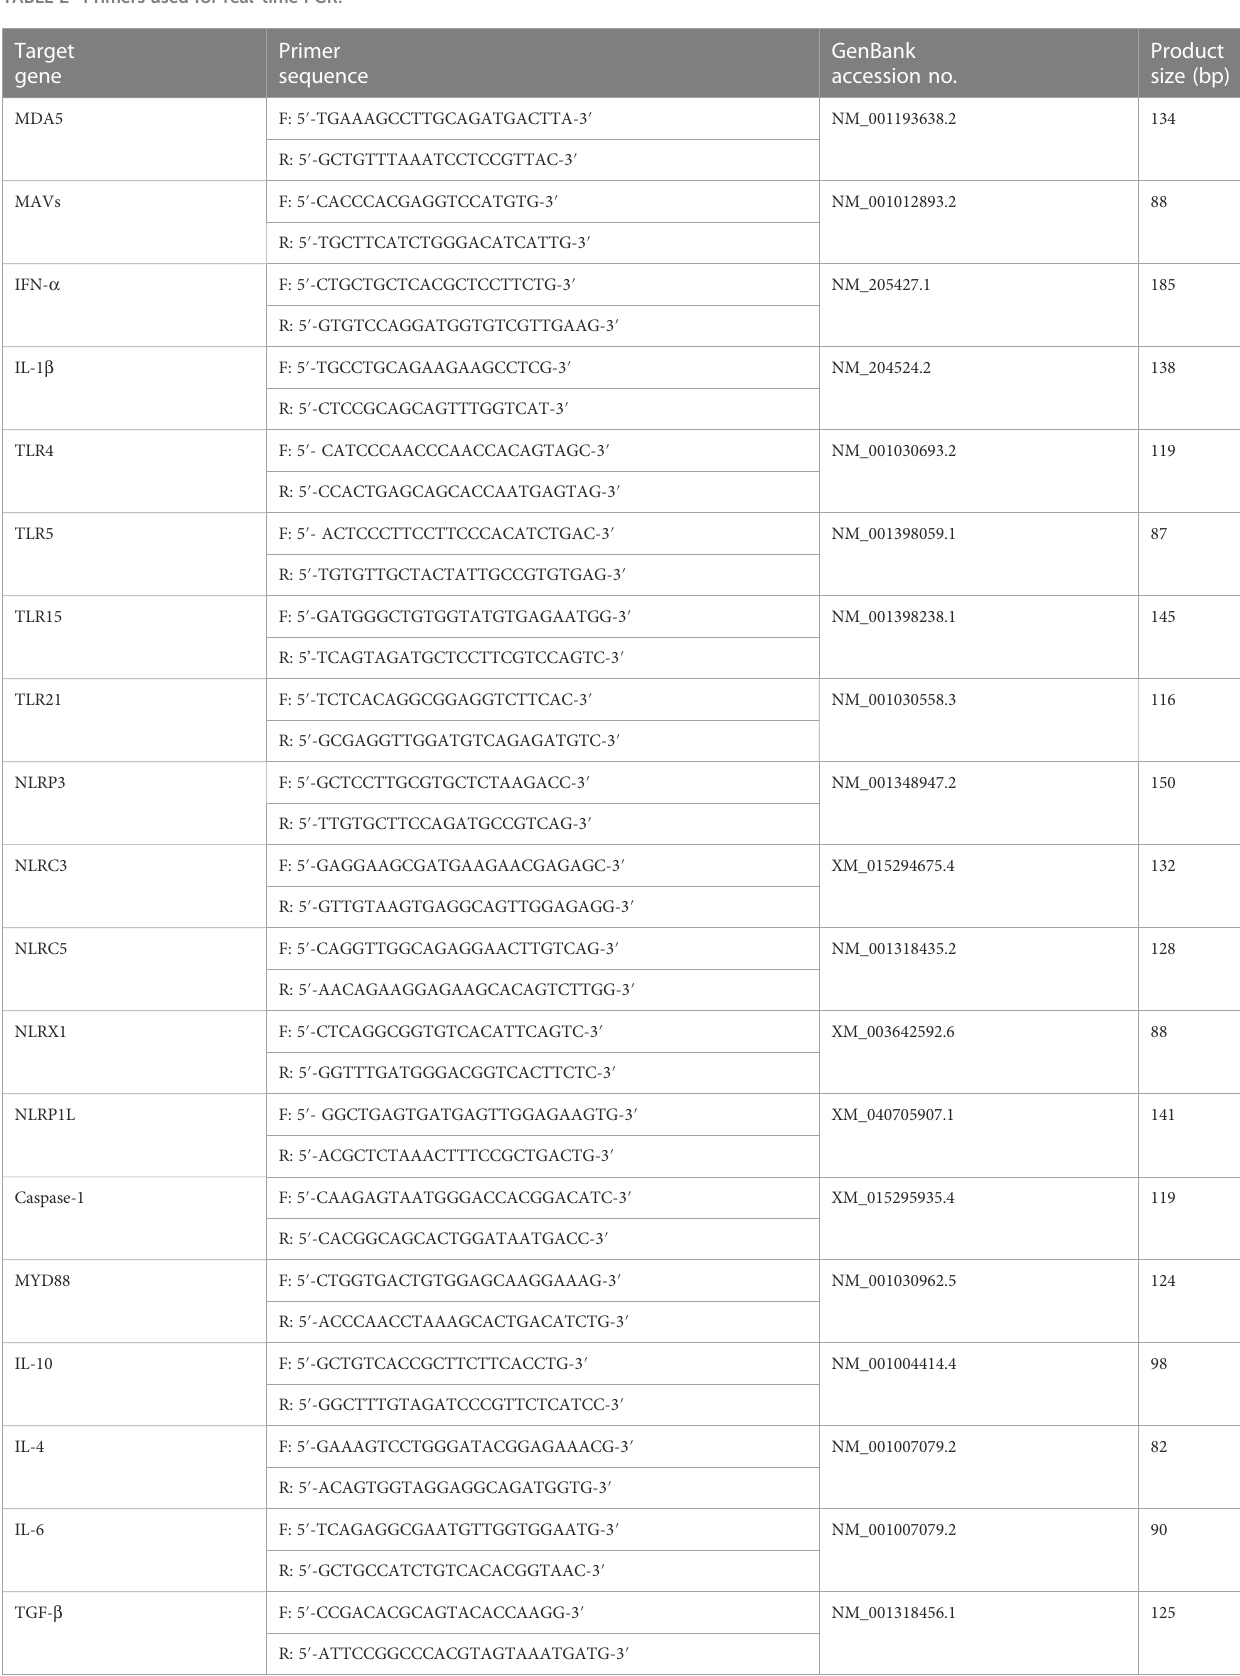
TABLE 2 Primers used for real-time